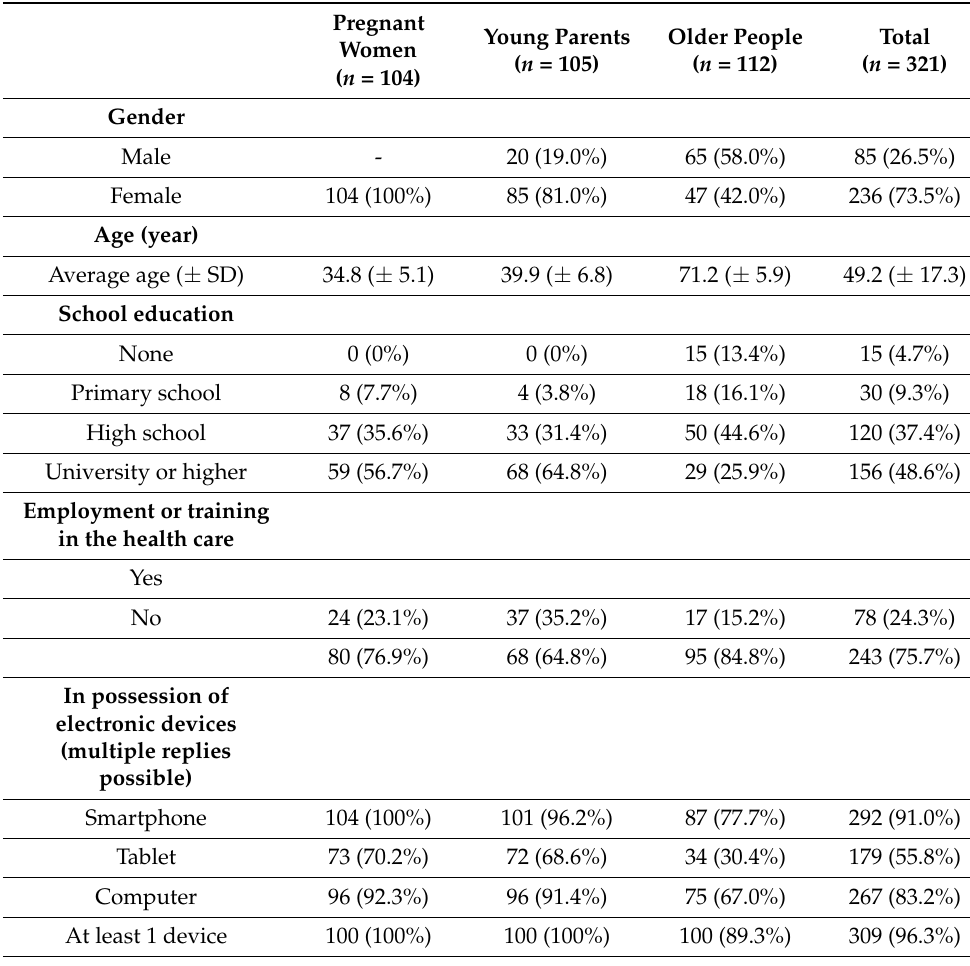
Table 1. Overview of the population characteristics of the respondents, for the three target